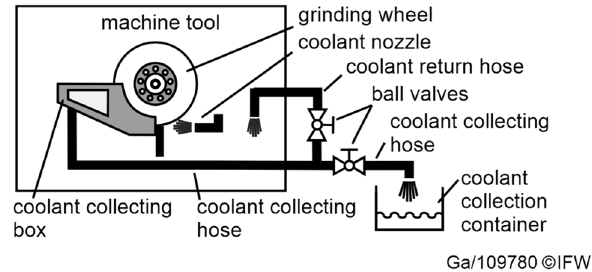
Fig. 6 Coolant guidance after the coolant collection box